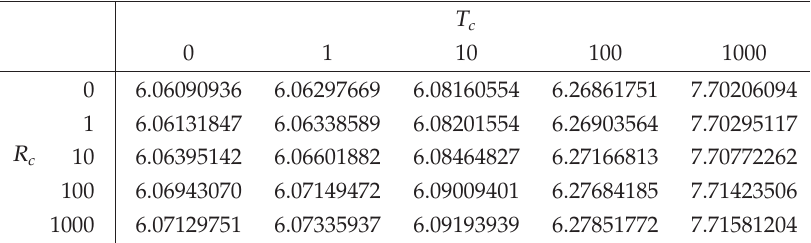
Table 5.4 . Values of coe ffi cients λ 3 for a beam with both ends and the intermediate point elastically restrained against rotation and translation.